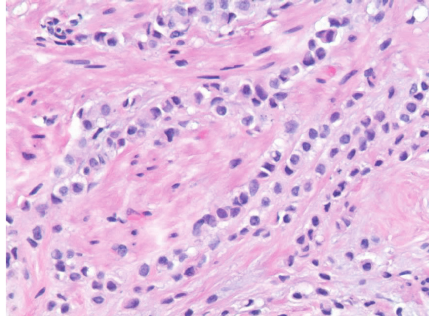
Figure 1: H&E stained slide demonstrating stromal infiltration by tumor cells arranged singly, in small clusters, and in single file pattern.